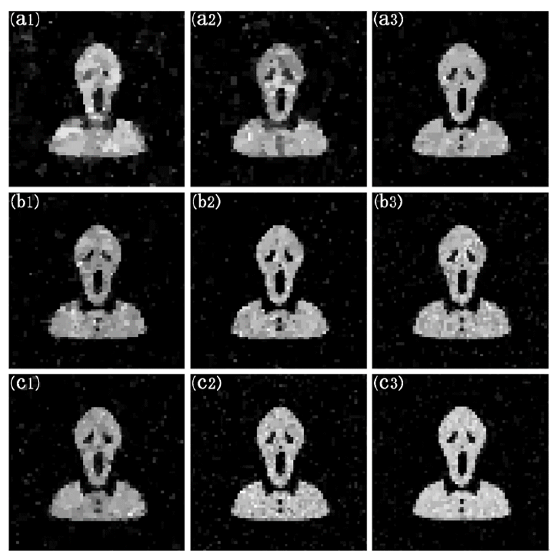
Fig. 7 Compressive SR s of the three groups of experiments [(a), (b), and (c)] are set to 0.25, 0.50, and 0.75, respectively. The sparsity ratio of each group is increased in turn, and the sparsity ratios of each group are set to 0.05, 0.10, and 0.15,